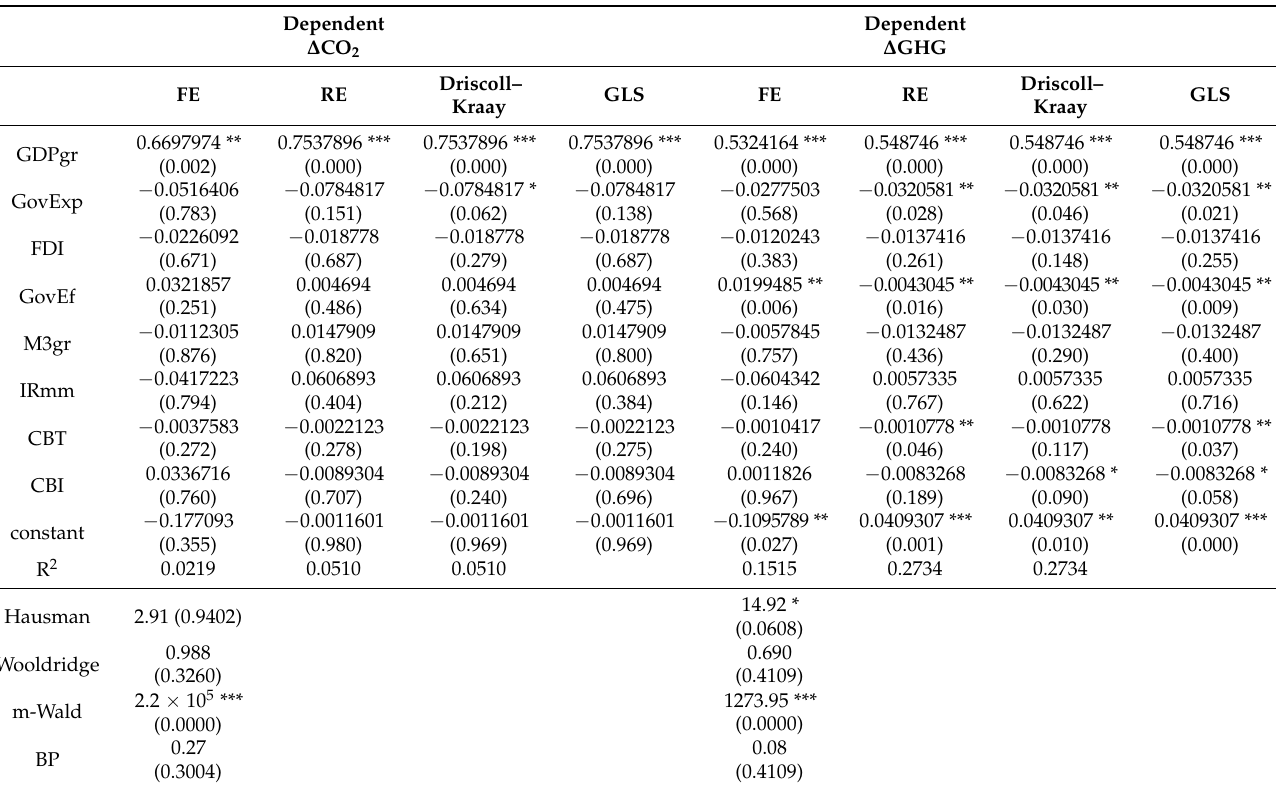
Table 6. Developed countries’ CO 2 and GHG